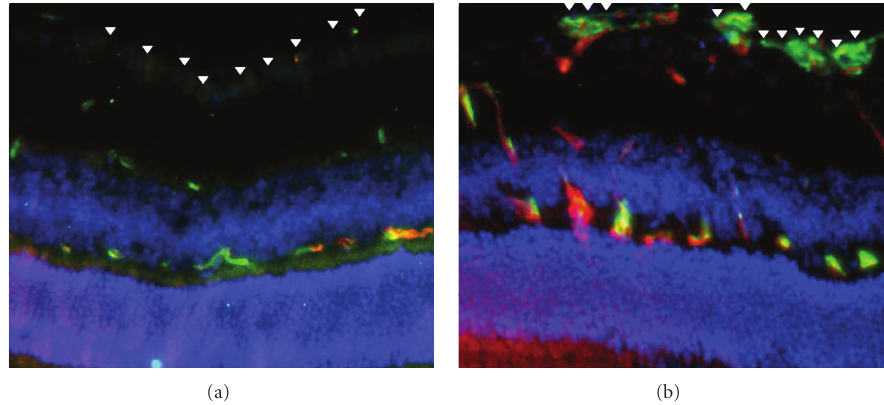
Figure 3: A2-expressing neovessels in oxygen-induced retinopathy in the mouse. Sections through retinas of wild type mice maintained in room air (a) or treated for five days with 75% oxygen to initiate oxygen-induced retinopathy (b) were stained with an endothelial cell-specific lectin (isolectin B4—green), 4 (cid:2) ,6-diamidino-2-phenylindole for nuclei (DAPI—blue), and anti-A2 (red) as described [32]. Note A2-positive neovascular tufts arrayed at the inner limiting membrane of the oxygen-treated retina (b, arrowheads) versus control (a, arrowheads).